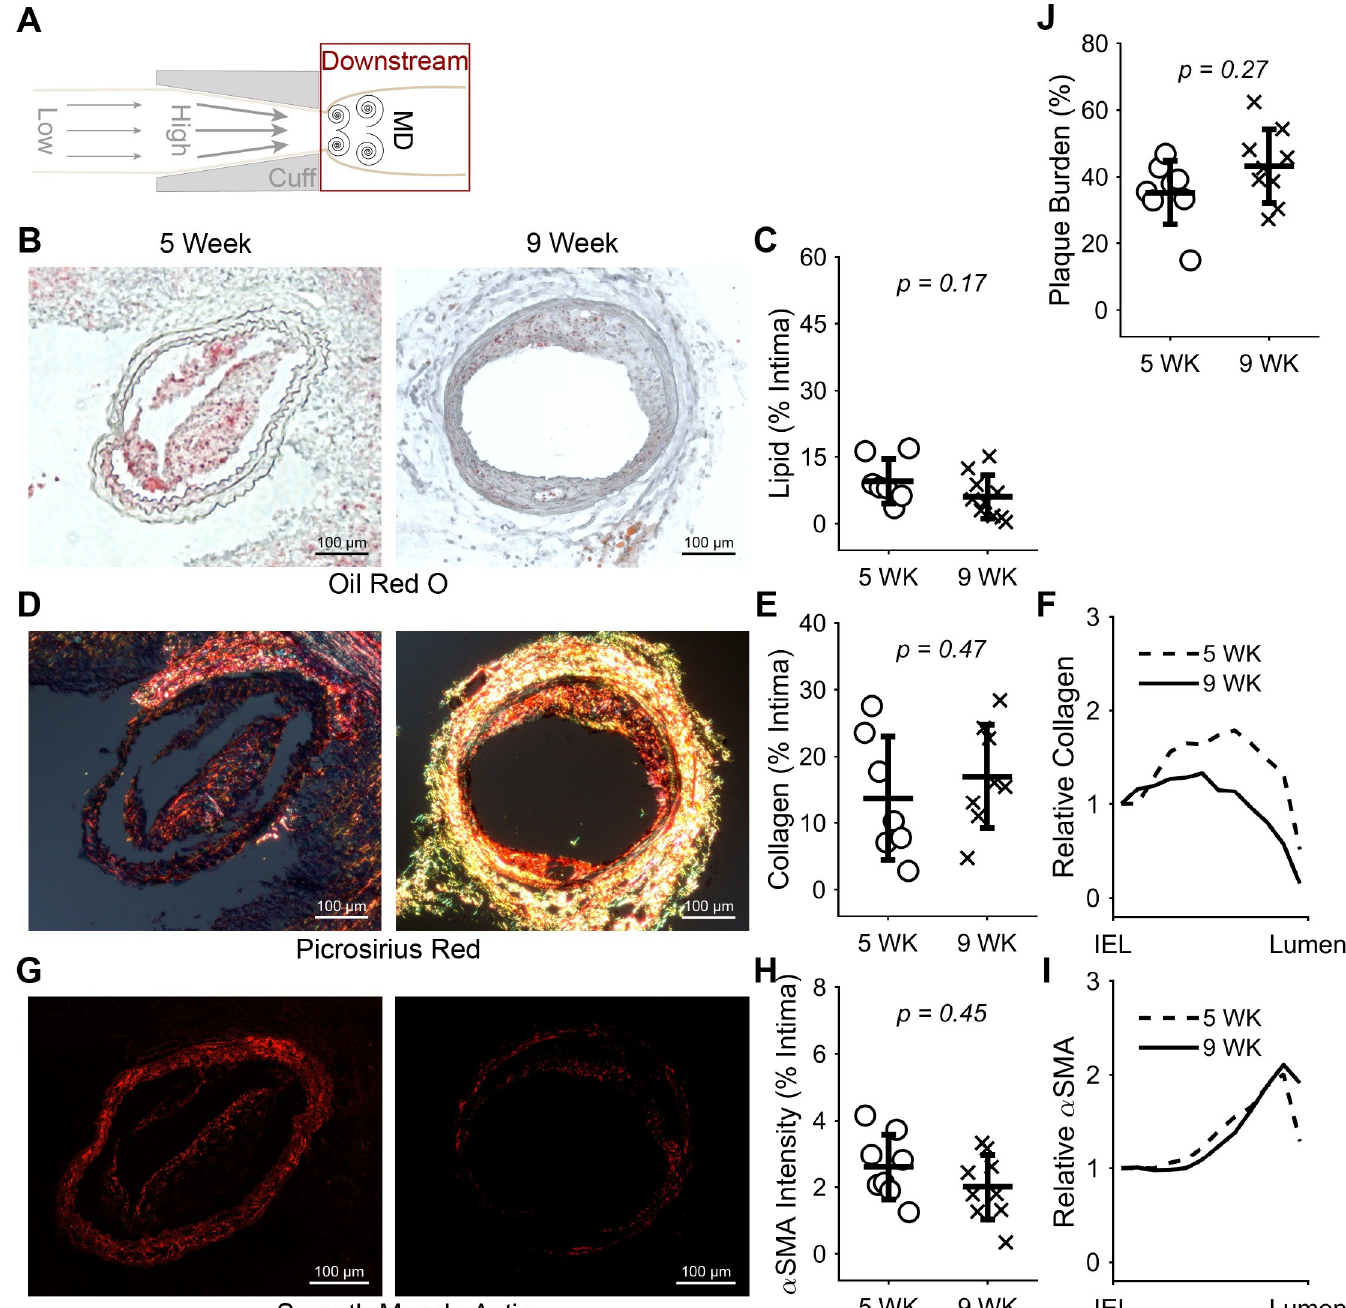
Fig 6. Constituents and size of plaques induced by multidirectional WSS at 5 versus 9 weeks. (A) Diagram of the instrumented carotid artery highlighting the focus of this figure on the multidirectional WSS (downstream) region. (B) Representative histology sections stained with oil red O to detect lipid and (C) plot of mean lipid area normalized by intima area across all mice at 5 ( n = 7 mice) and 9 ( n = 10) weeks after cuff placement. (D) Representative histology sections stained with picrosirius red to detect collagen, (E) plot of mean collagen area normalized by intima area at 5 ( n = 7) and 9 ( n = 8) weeks, and (F) plot of mean collagen distribution from the IEL to the lumen normalized by the value at the IEL at 5 and 9 weeks. (G) Representative histology sections stained for α -SMA, (H) plot of mean α -SMA intensity normalized by intima area at 5 ( n = 8) and 9 ( n = 10) weeks, and (I) plot of mean α -SMA intensity distribution from the IEL to the lumen normalized by the value at the IEL at 5 and 9 weeks. (J) Plot of mean plaque burden at 5 and 9 weeks. In the scatter plots, each data point represents the average of all viable histological sections for the given stain in the plaque region of the downstream vessel segment of one mouse. Bars are mean ± SD. � P < 0.05 is considered statistically significant.